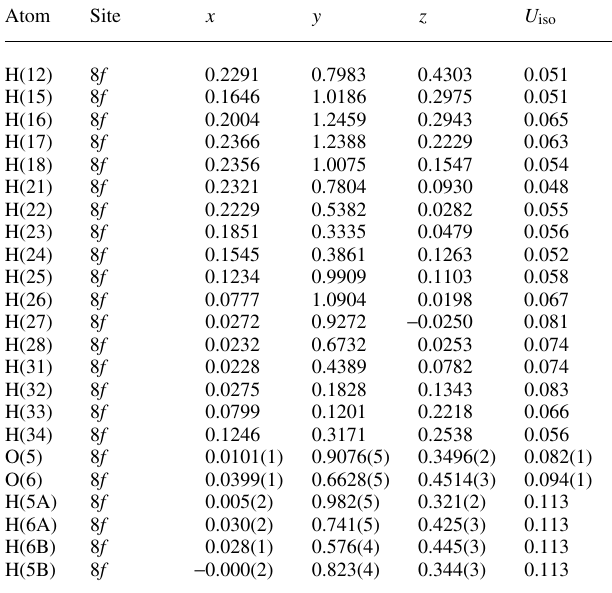
Table 1. Data collection and